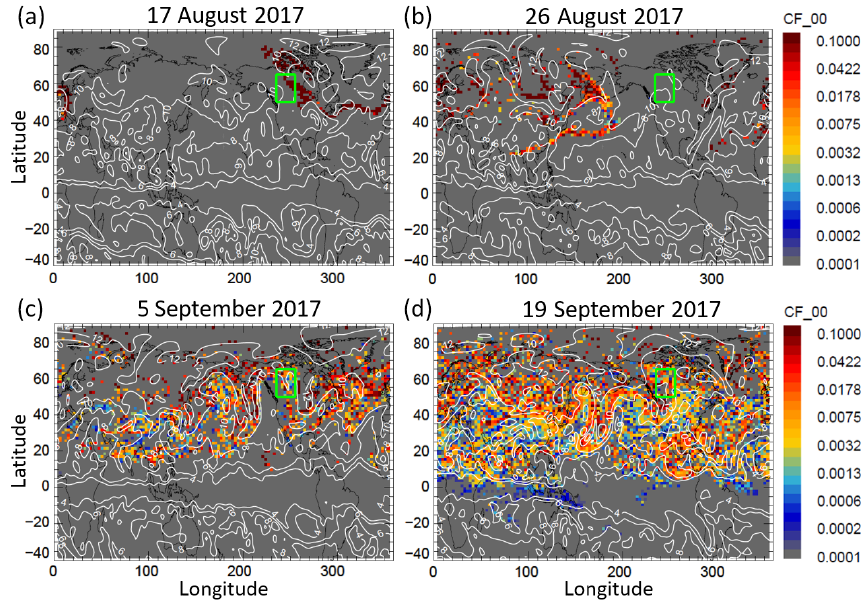
Figure D1. Same as Fig. 3 at 400K potential temperature.